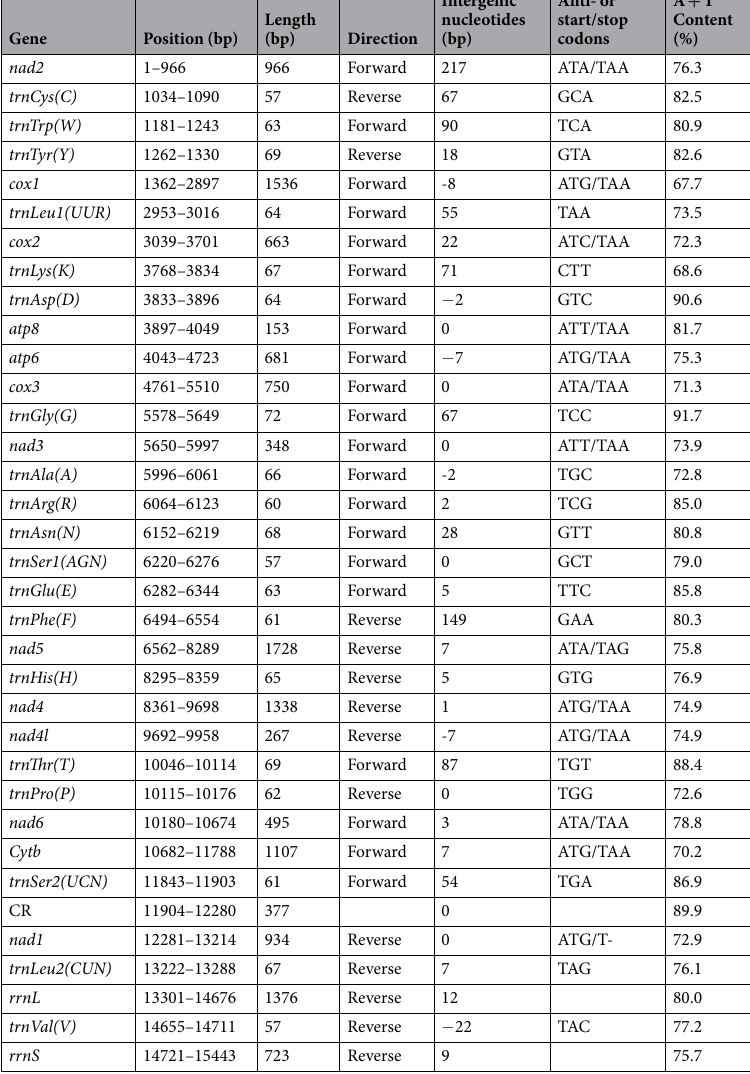
Table 2. Gene structure of the mitogenome of Aposthonia borneensis